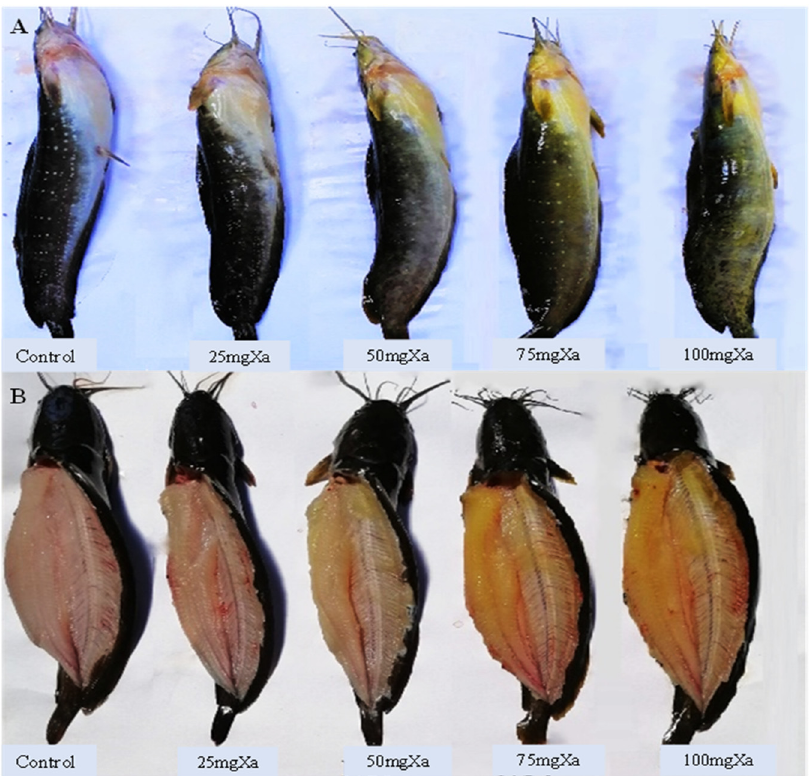
Fig(cid:31)re 8. Digital image of body skin ( A ) and muscle ( B ) of bighead catfish fed Xa diets for 4 weeks.